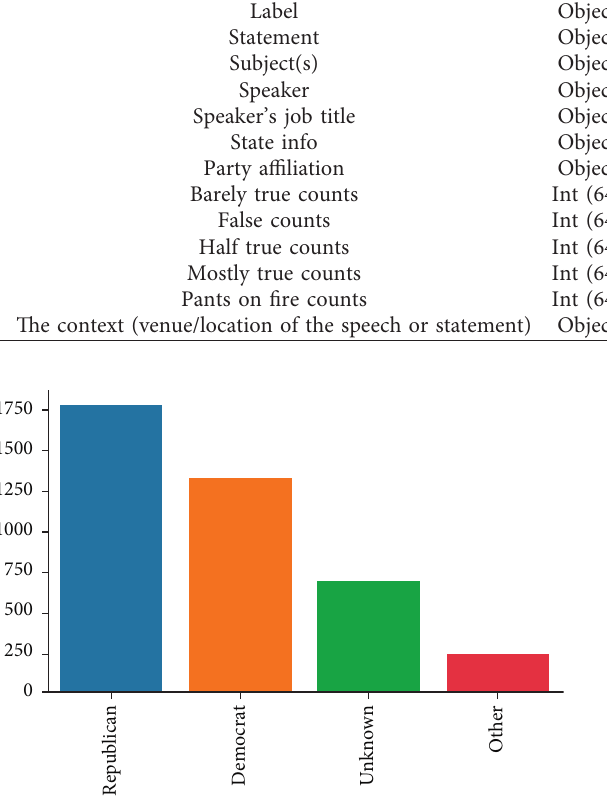
Figure 2: Number of records per category for party affiliation attribute.